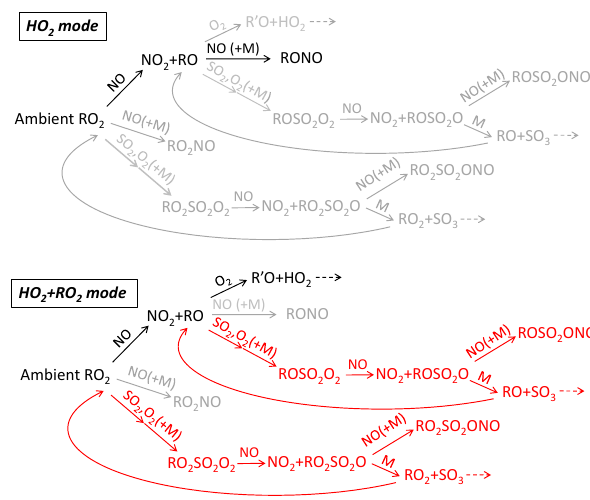
Scheme 1. PeRCIMS inlet RO 2 chemistry in the HO 2 mode and HO 2 +RO 2 mode. Reactions in black are known reactions (see text). Reactions in grey are deemed either unimportant or sup- pressed by competing reactions. Reactions in red show proposed chemistry based on inlet chemistry modeling (Sect. 3.2.3).